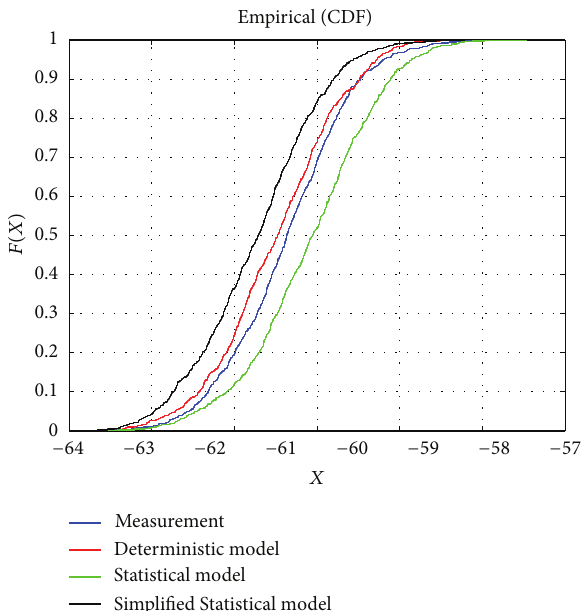
Figure 13: Distribution of received power of channel elements in uplink.